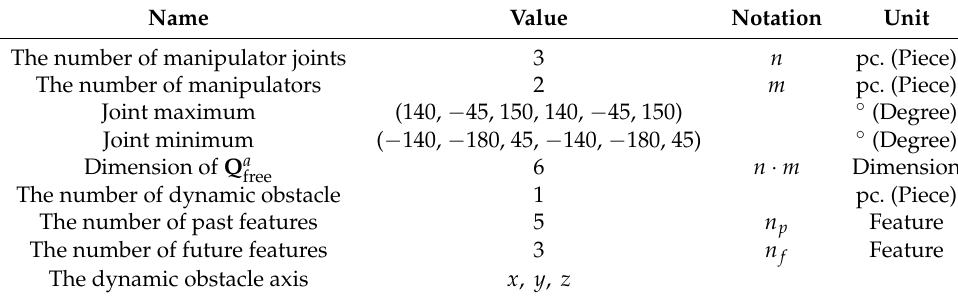
Table 1. Parameters of the 3-DOF manipulator and environment.